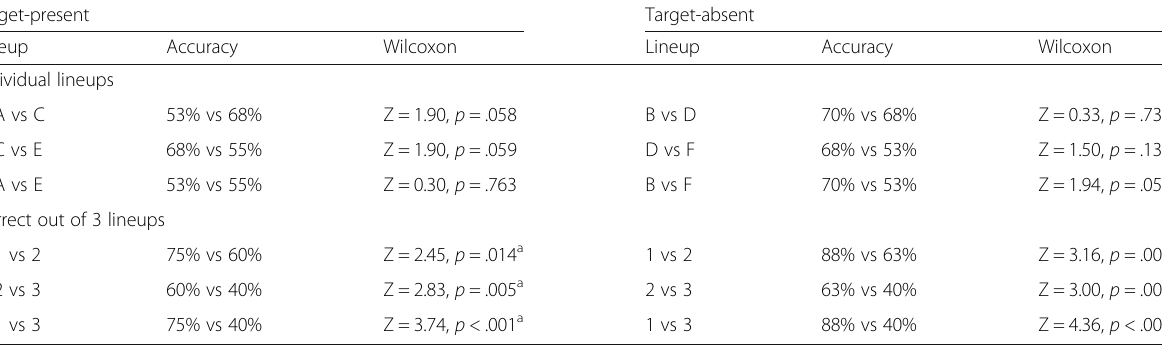
Table 1 A summary of statistical comparisons (Wilcoxon signed-rank test) for individual lineup accuracy and for accuracy out of three lineups in Experiment